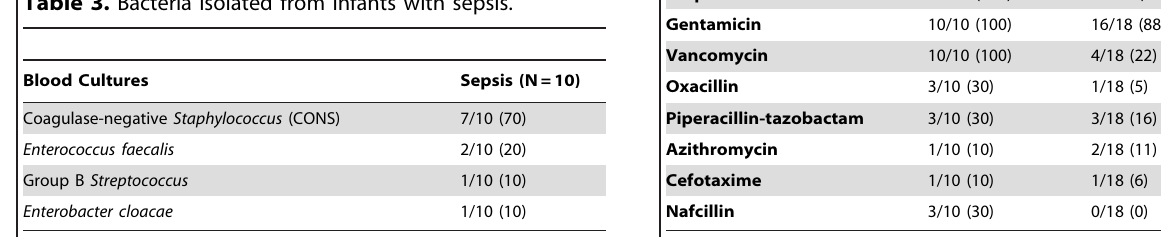
Table 3. Bacteria isolated from infants with sepsis.